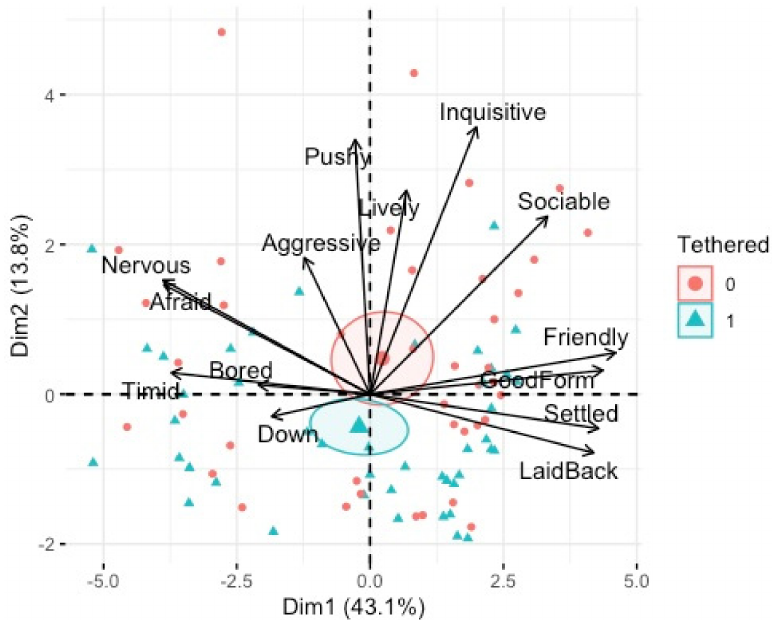
Figure 7. PCA bi-plot of QBA terms associated with individual horses who had shelter available (1) or not (0). Dimension 1 (mood) and Dimension 2 (energy).